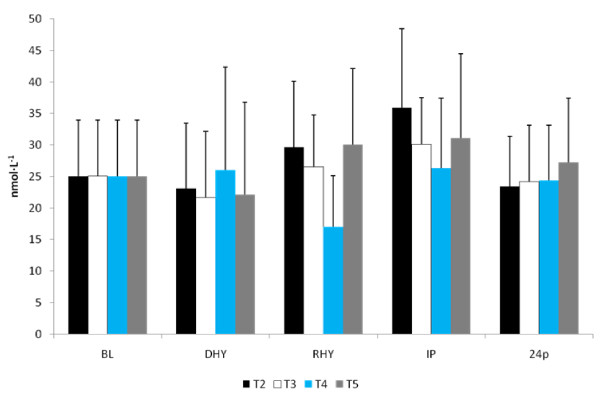
Testosterone Response.